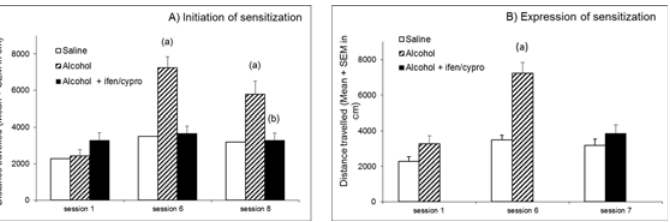
Fig 2. Effect of a treatment by ifenprodil + cyproheptadine in combination on alcohol induced sensitization. Y axis: distance travelled in cm (mean ± S.E.M.) A) Initiation of sensitization Session 1: all groups (N = 8 animals per group) received two saline administrations, 15 min and 30 min after being placed in the actimeter. Sessions 2 to 8: groups received saline or ifenprodil 1 mg/kg + cyproheptadine 1 mg/kg and then saline or alcohol (1g/kg ip/session), as indicated in materials and methods. Statistical analyses: repeated measures ANOVA, group effect F 2;21 = 14.2, p < 0.001, session effect F 2;42 = 22.6, p < 0.001, group × session interaction F 4;42 = 9.5, p < 0.001; one-way ANOVAs, differences between groups in session 1